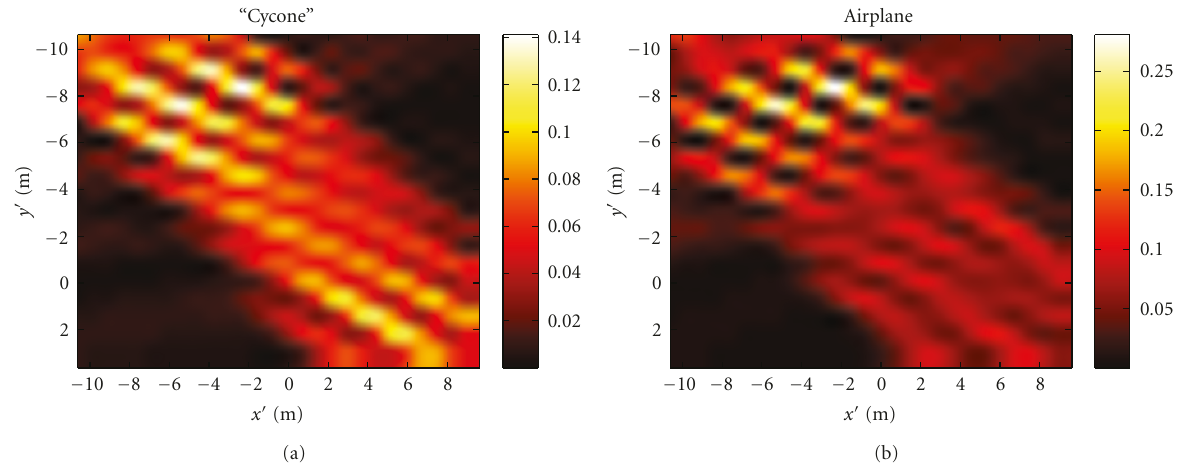
Figure 13: Bistatic image in copolarization of the “cycone” (a) and airplane (b).